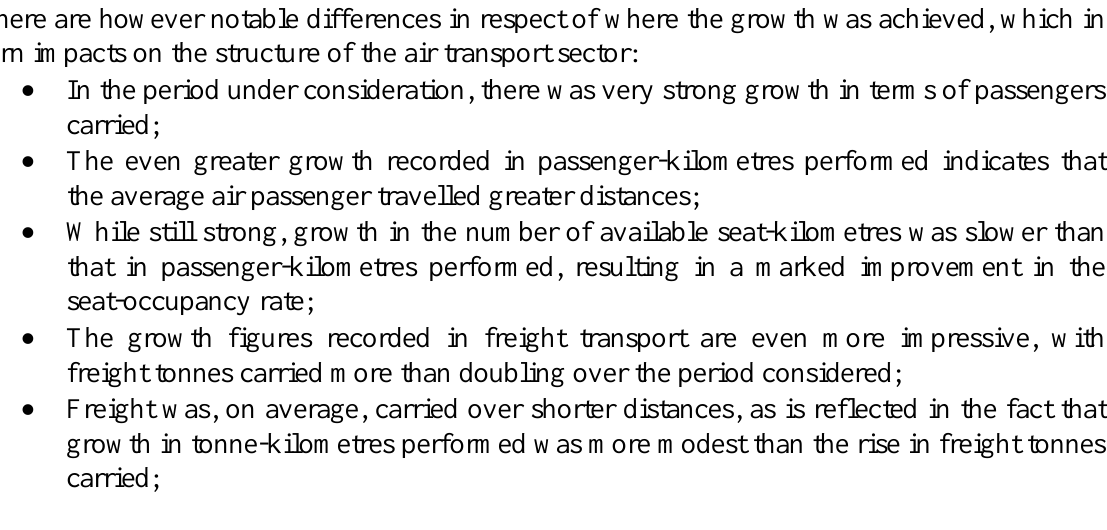
Table 1. World air transport: growth figures (1991-2005, scheduled services, domestic + international) Indicator Growth rate (%) Passengers carried 81.8 Tonne-kilometres performed Available tonne-kilometres 101 Source: IATA